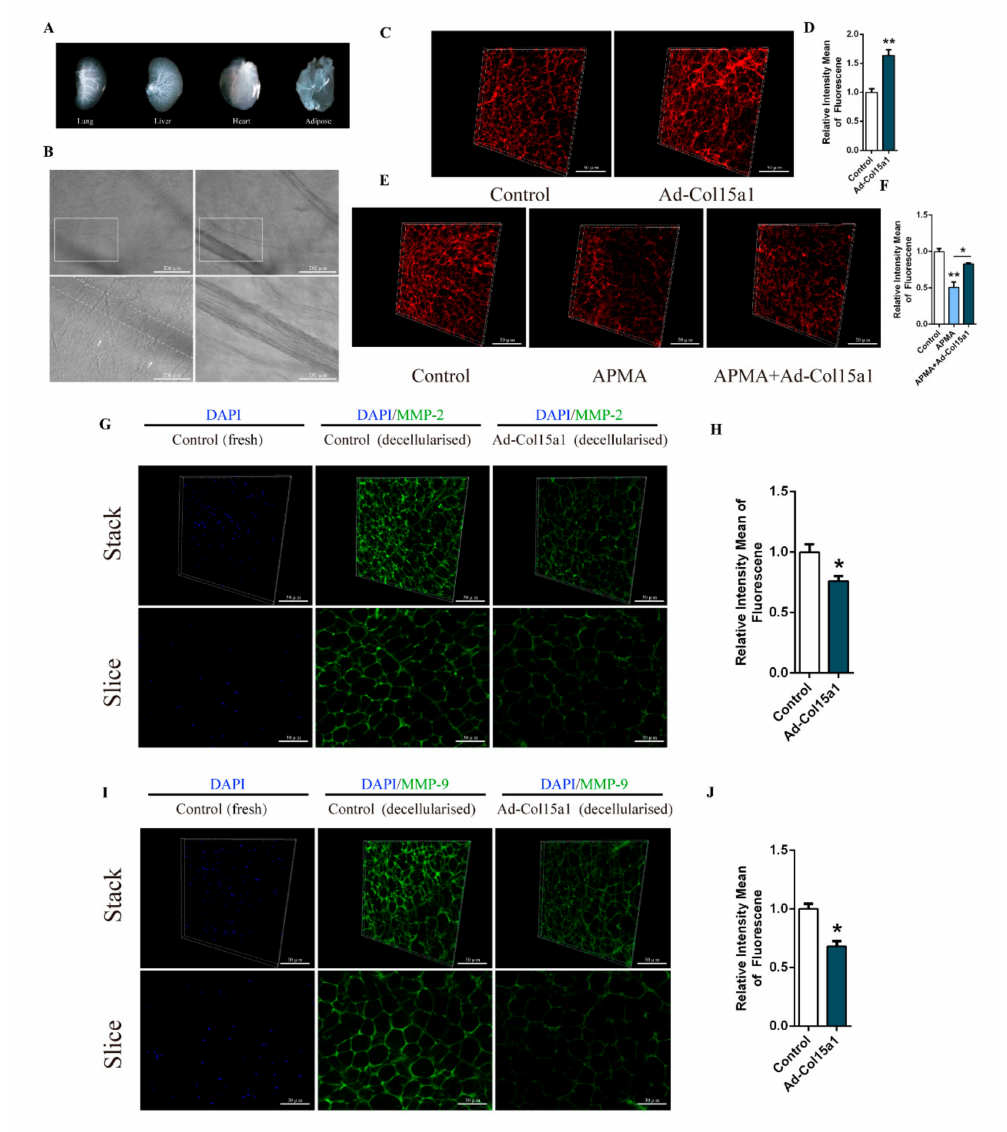
Figure 6. Z-stack analysis and three-dimensional reconstruction of adipose tissue ECM under decellularized conditions. ( A ) Images of decellularized lung, liver, heart and iWAT. ( B ) Representative images of ECM structural integrity and transparency detection in decellularized iWAT. Scale bar, 100 µ m (top) and 30 µ m (bottom) ( n = 4). White rectangle represents the images of di ff erent focal lengths at the same position (left and right). Arrowheads indicate collagen bundles and right images indicate complete microvascular structure in decellularized iWAT. ( C – D ) Representative images of the 3-dimensional structure by Col I immunofluorescent staining of two di ff erent groups in decellularized iWAT. Scale bar, 50 µ m ( n = 4). ( E – F ) Representative images of the 3-dimensional structure by Col VI immunofluorescent staining of three di ff erent groups in decellularized iWAT. Scale bar, 50 µ m ( n = 4). ( G – H ) Representative images of the 3-dimensional structure by MMP-2 immunofluorescent staining and DAPI staining of two di ff erent groups in decellularized iWAT (two columns on the right). DAPI staining in un-decellularized iWAT(left). Scale bar, 50 µ m ( n = 4). Slice (bottom) represents one of the images composed of the Stack. Scale bar, 30 µ m ( n = 4). ( I – J ) Representative images of the 3-dimensional structure by MMP-9 immunofluorescent staining and DAPI staining of two di ff erent groups in decellularized iWAT (two columns on the right). DAPI staining in un-decellularized iWAT(left). Scale bar, 50 µ m ( n = 4). Slice (bottom) represents one of the images composed of the Stack. Scale bar, 30 µ m (n = 4). Values are presented as mean ± SEM. * p < 0.05, ** p <